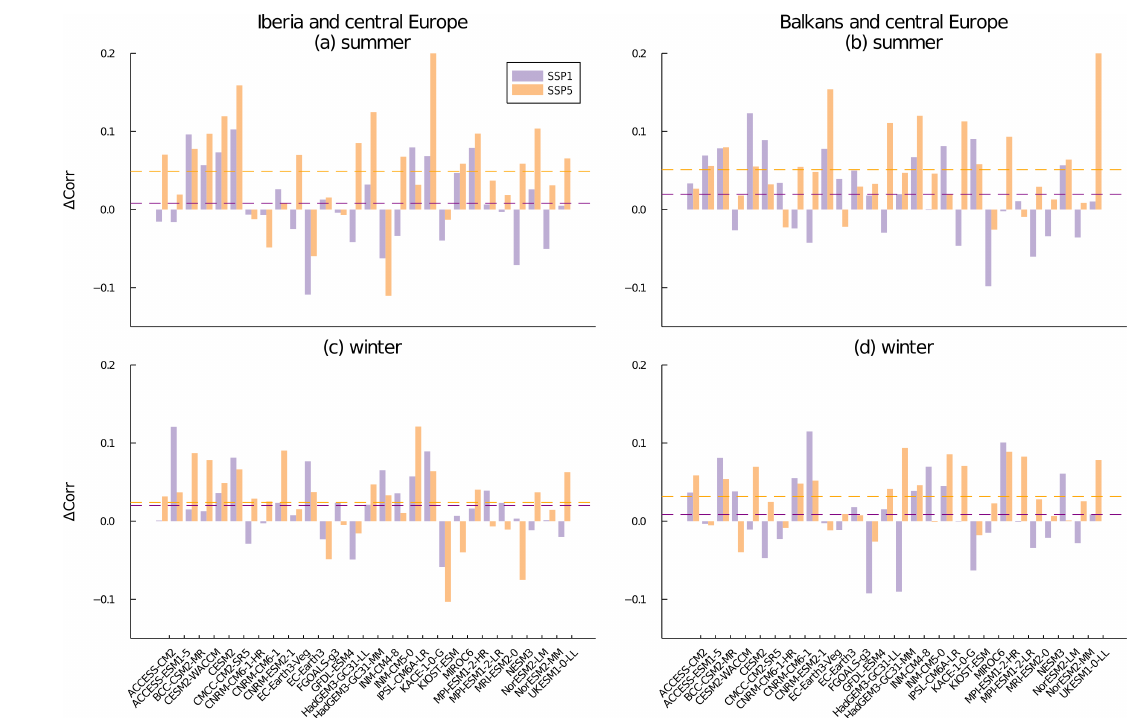
Figure 7. Change in spatial correlation of daily PV electricity production in SSP1-2.6 (purple) and SSP5-8.5 (orange) for balancing PV electricity in central Europe with Iberia (a, c) and the Balkans (b, d) in summer (a, b) and winter (c, d) by alphabetically sorted models. The dashed lines in the same color as the scenario denote the mean of the correlation